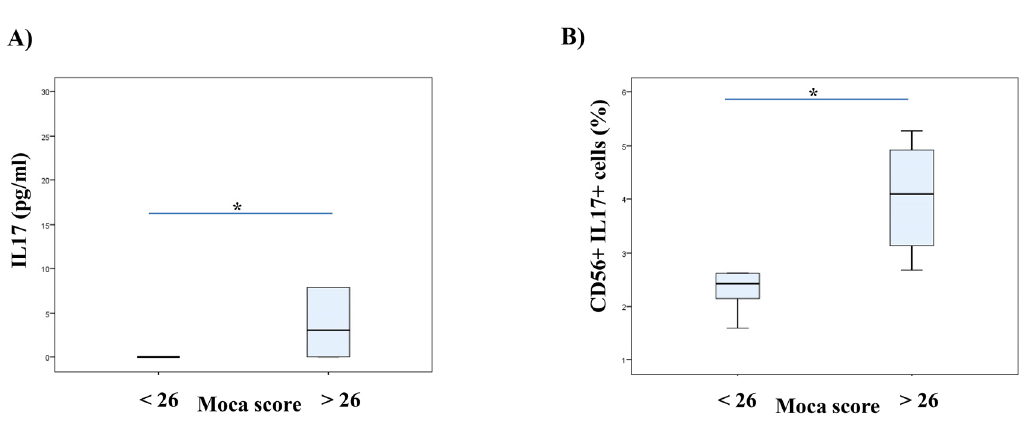
Figure 1. Serum concentrations of IL-17 and the percentage of NK cells secreting IL-17 regarding cognition of patients with stable schizophrenia. Patients with stable schizophrenia in remission were divided into two groups based on MoCA scores (score 26 as a cut-off value). The serum levels of IL-17 were determined by ELISA and IL-17 production of NK cells was examined by flow cytometry. The Student’s t or Mann–Whitney U test was applied to evaluate statistically significant differences between two groups, * p < 0.05. In patients with higher MoCA scores were detected higher serum concentrations of IL-17 ( A ) and also the higher percentage of IL-17 secreting CD56 + NK cells ( B ). MoCA—Montreal-Cognitive Assessment; NK–Natural Killer Cells.